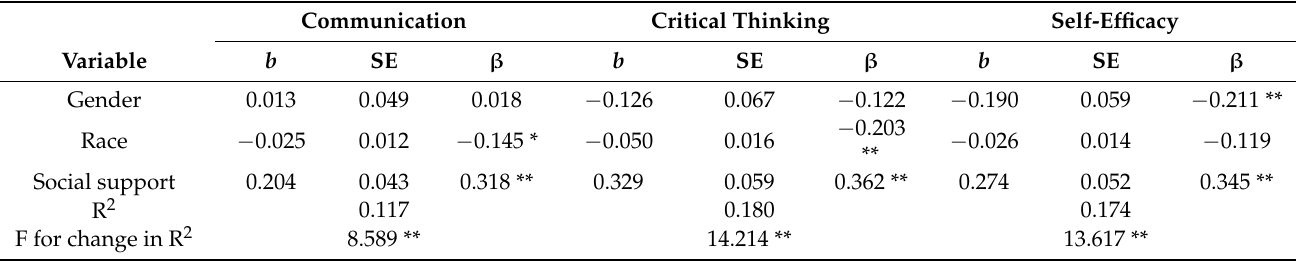
Table 3. Summary of regression analyses for the association between social support and personal resources. Communication Critical Thinking